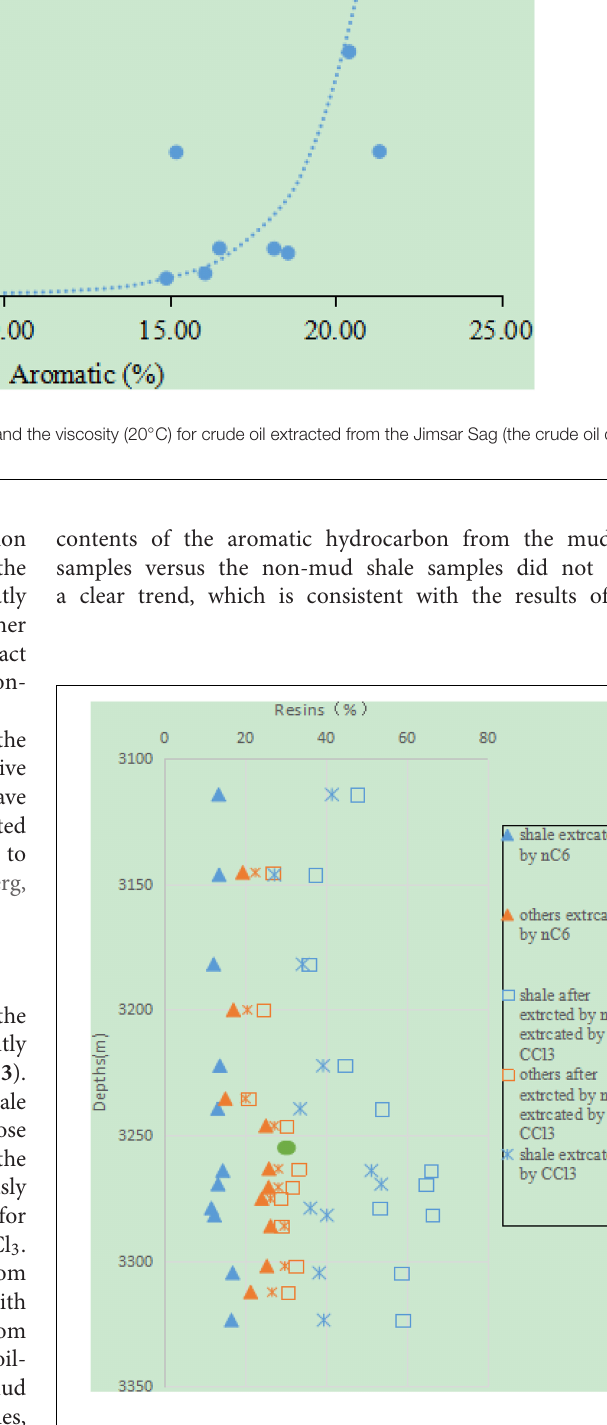
Frontiers in Earth Science |